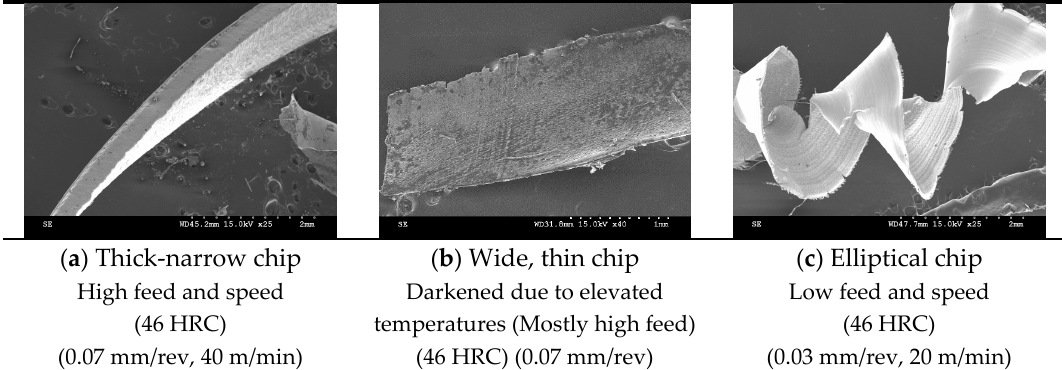
Figure 17. Different types of chip morphology observed. ( a ) Thick-narrow chip; ( b ) Wide, thin chip; ( c ) Elliptical chip.